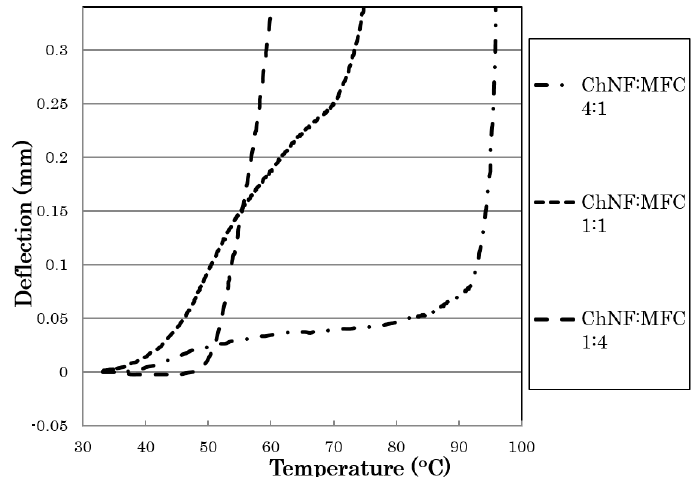
Figure 6. Heat deflection temperature (HDT) curves by the Method A (load of 1.8 MPa) of nanocomposites with 50 wt % reinforcing phase with varying chitin nanofiber (ChNF) to microfibrillated cellulose (MFC) ratios.